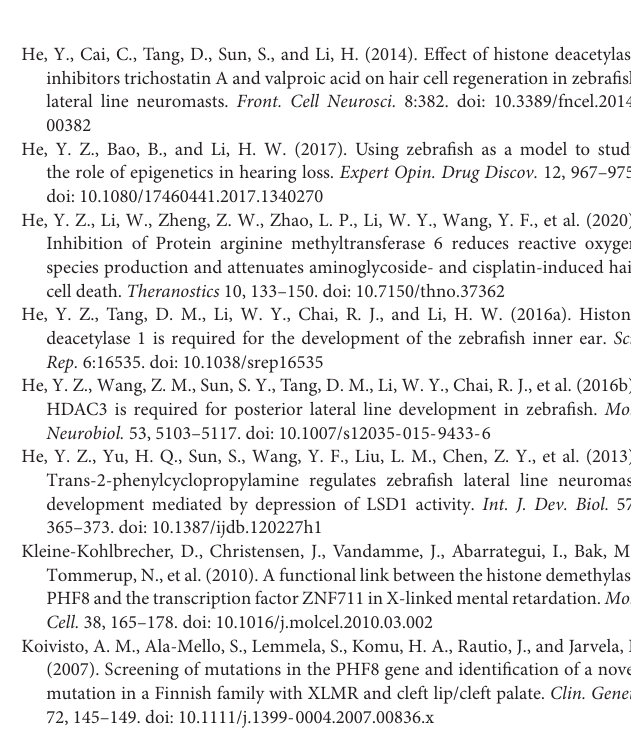
Supplementary Figure 1 | (A) The effectiveness of PHF8-MO was detected by RT-PCR at 24 hpf. (B) Gross phenotypic morphology of control and PHF8 morphant embryo. Supplementary Figure 2 | Expression of pax2 , fgf3, and fgf8 in the zebrafish embryos at 12 hpf. (A–F) WISH was utilized to examine the expression of pax2 (A,B) , fgf3 (C,D) , and fgf8 (E,F) at 12